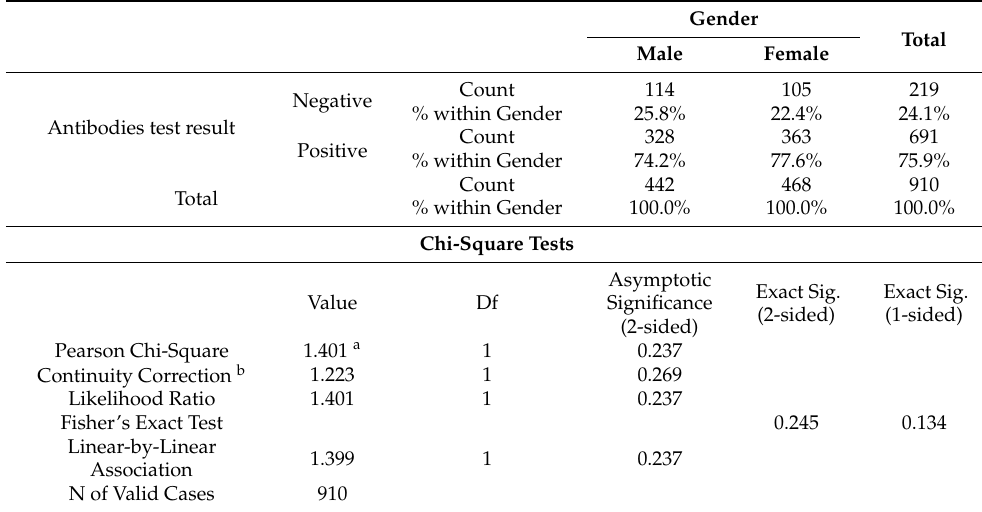
Table 3. Antibodies test results irrespective of the source (infection or vaccine) by